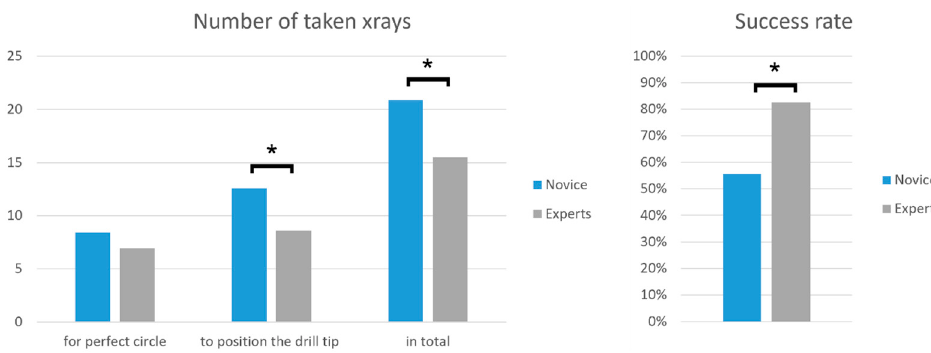
Figure 5. Comparison of novice (blue) and expert (grey) performance based on the captured metrics. Numbers of taken X-rays (left) and success rate (hit/miss ratio) (right). Stars indicate significant dif- ferences between the groups.